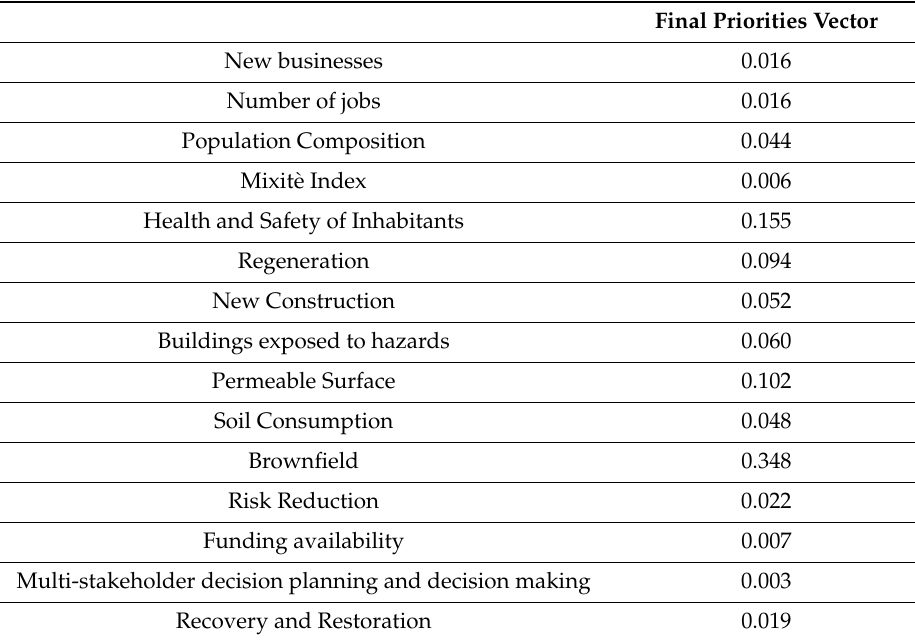
Table 5. Final vector